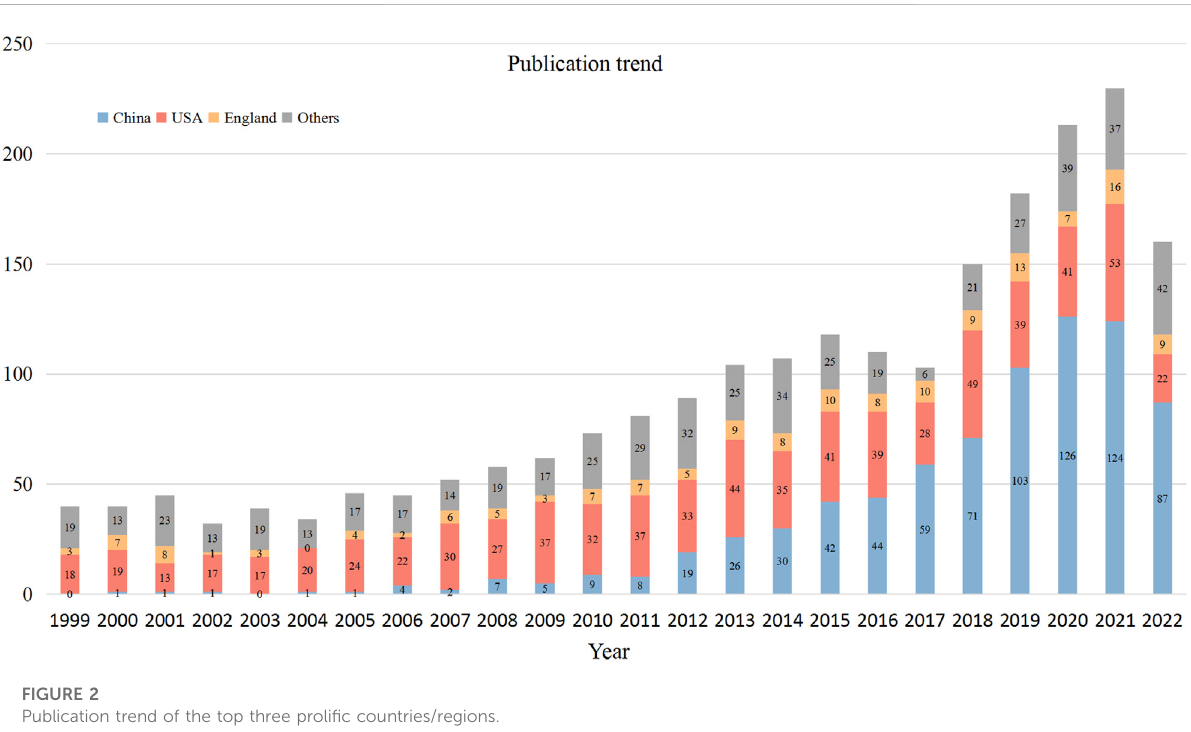
FIGURE 2 Publication trend of the top three proli fi c countries/regions.